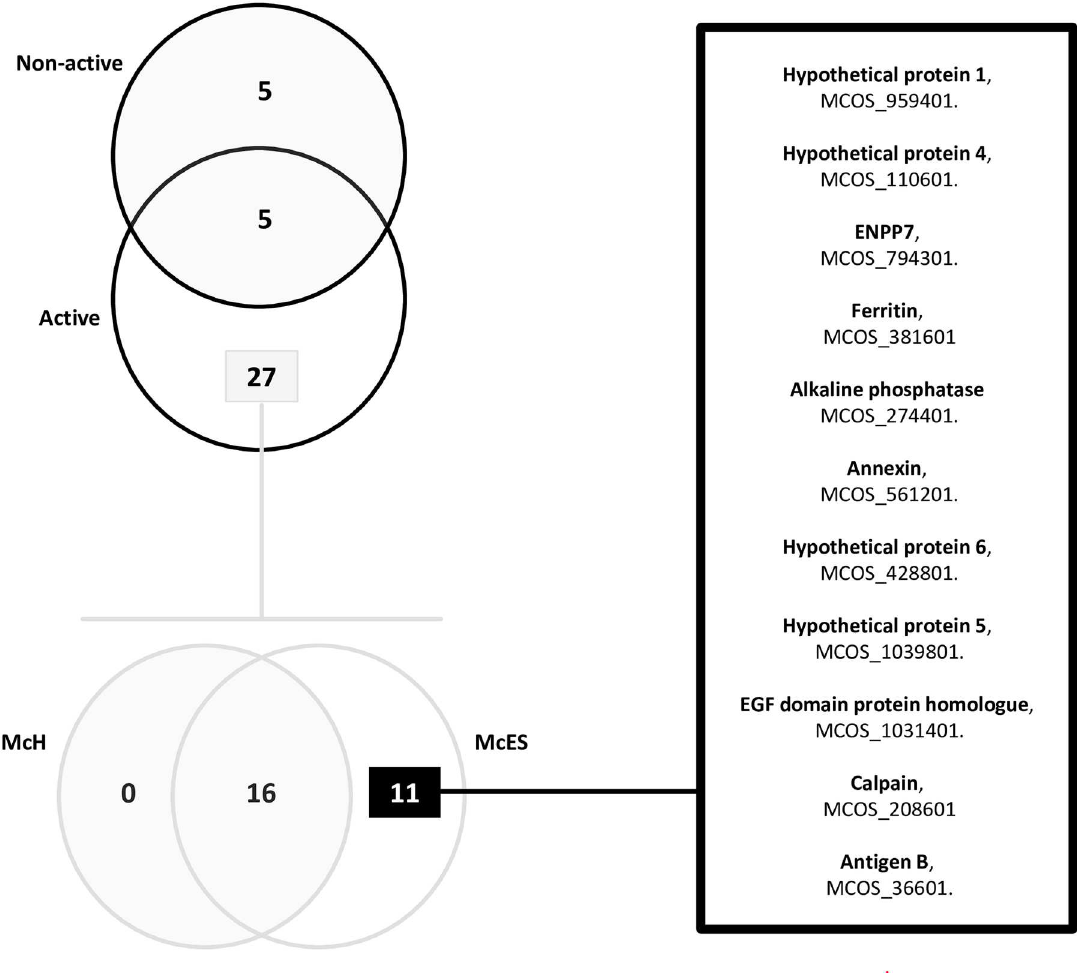
Fig 11. Distribution profile of proteins identified in McES fractions. Venn diagramof all proteins detected in McES fractions (Upper left) of which proteins exclusivelypresent in McES active fractions are further distributedaccordingto their detection in McH and McES (Lower left). A refined list of proteins exclusive to active preparations (immunomodulatory fractions and McES) of M . corti products is provided.